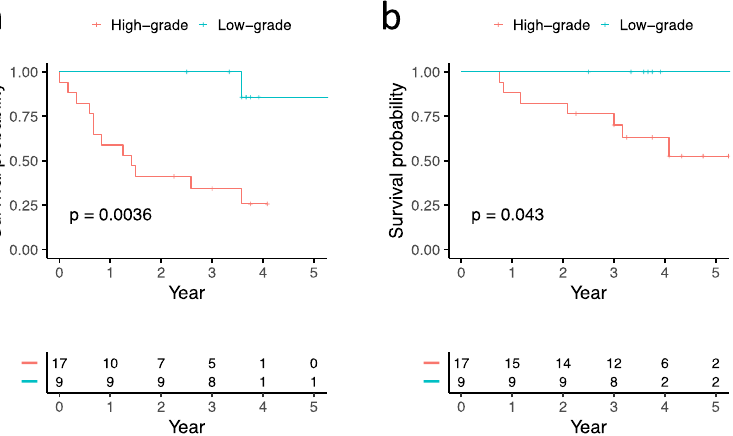
Figure 2. Kaplan–Meier survival analysis showed that the low-grade subtype group had superior ( a ) disease-free survival and ( b ) overall survival than the high-grade subtype group ( p = 0.0036 and p = 0.043, respectively).